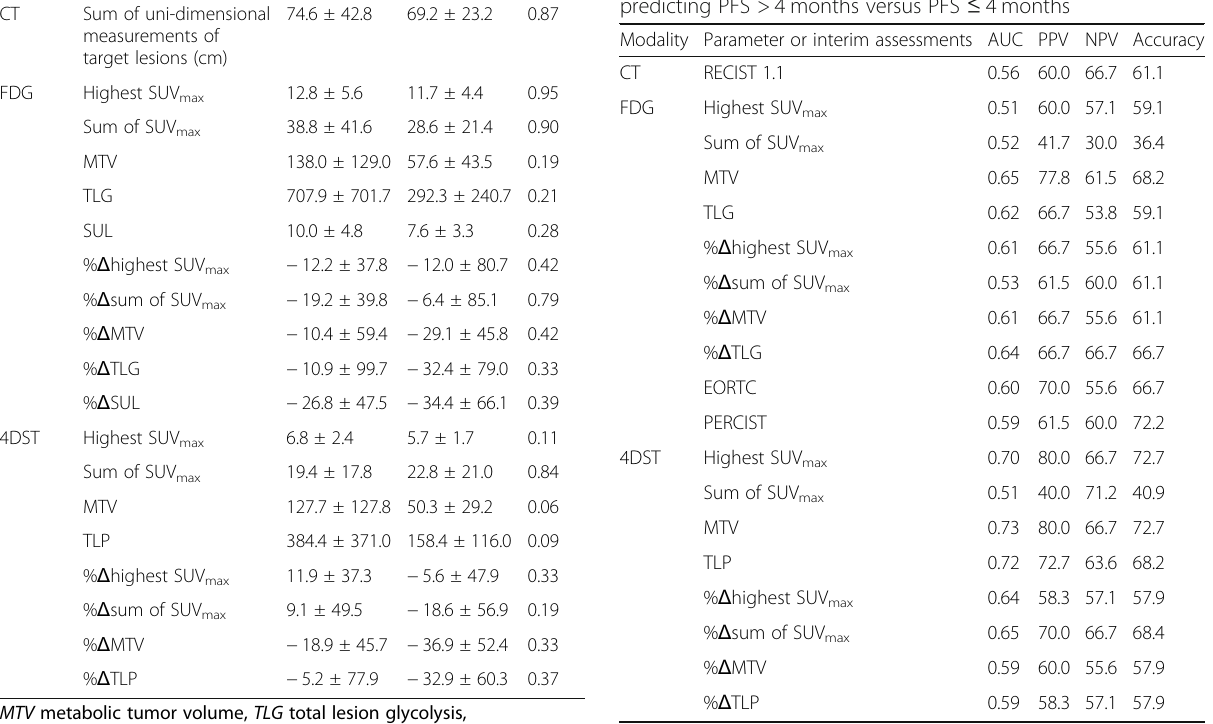
of baseline 4DST ( p = 0.007) revealed significant results (Table 5, Figs. 2 and 3). Discussion The present study evaluated 4DST PET/CT for predict- ing patient prognosis from baseline data and interim Table 4 Results of ROC analysis and PPV, NPV, and accuracy